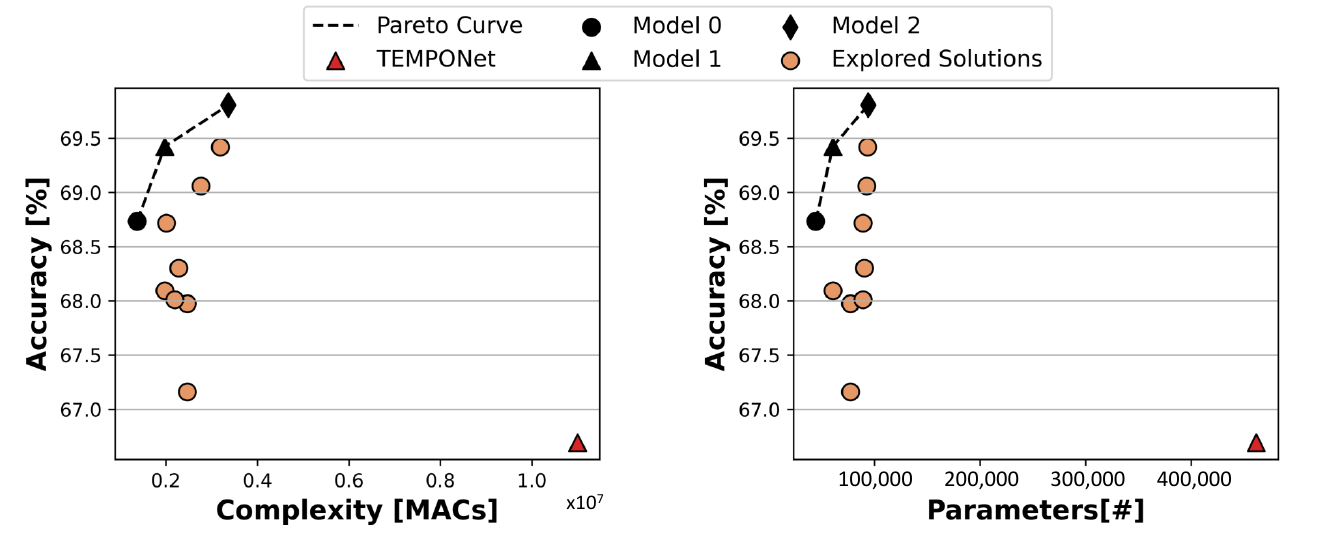
Figure 5. Network topology exploration results. Pareto-optimal solutions are highlighted in the two graphs by black dashed